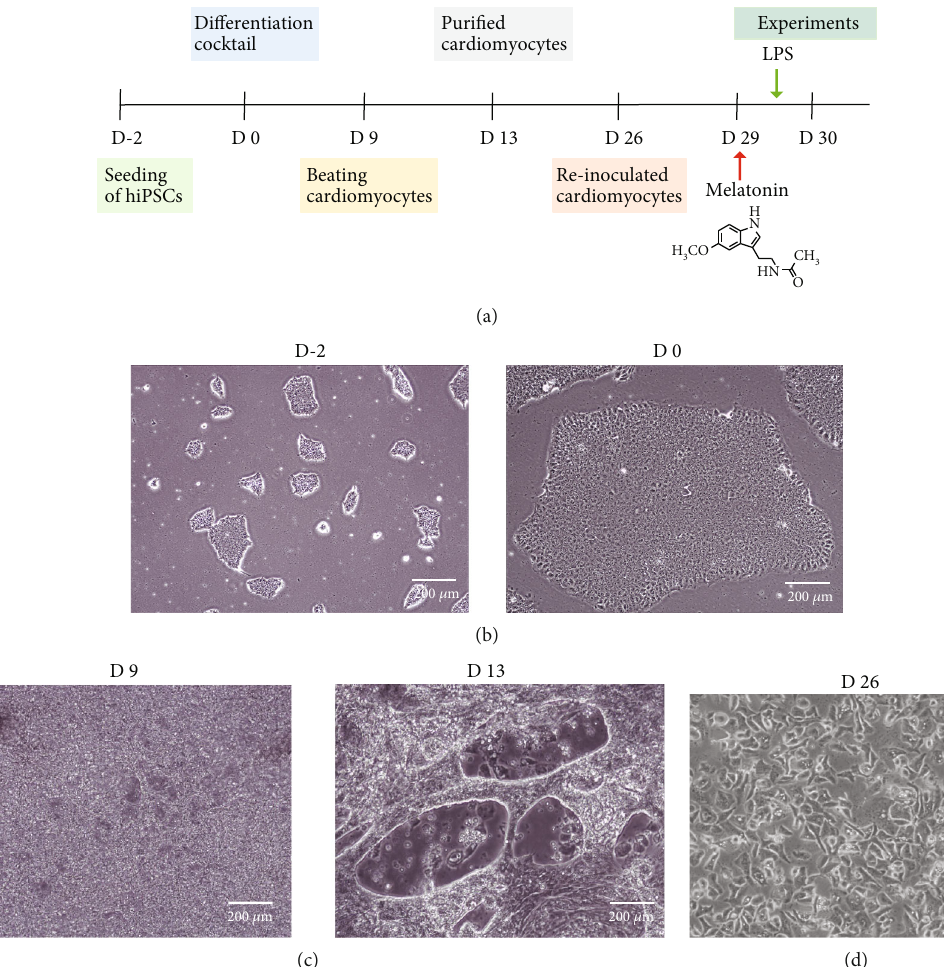
Figure 1: Experimental timeline and cell culture. (a) Flow chart of experiments. (b) Bright- fi eld images of cultured hiPSCs. Scale bars: 200 μ m. (c) Bright- fi eld images of beating cardiomyocytes on day 9 and puri fi ed cardiomyocytes on day 13. Scale bars: 200 μ m. (d) Bright- fi eld images of puri fi ed and reinoculated hiPSC-CMs. Scale bars: 200 μ